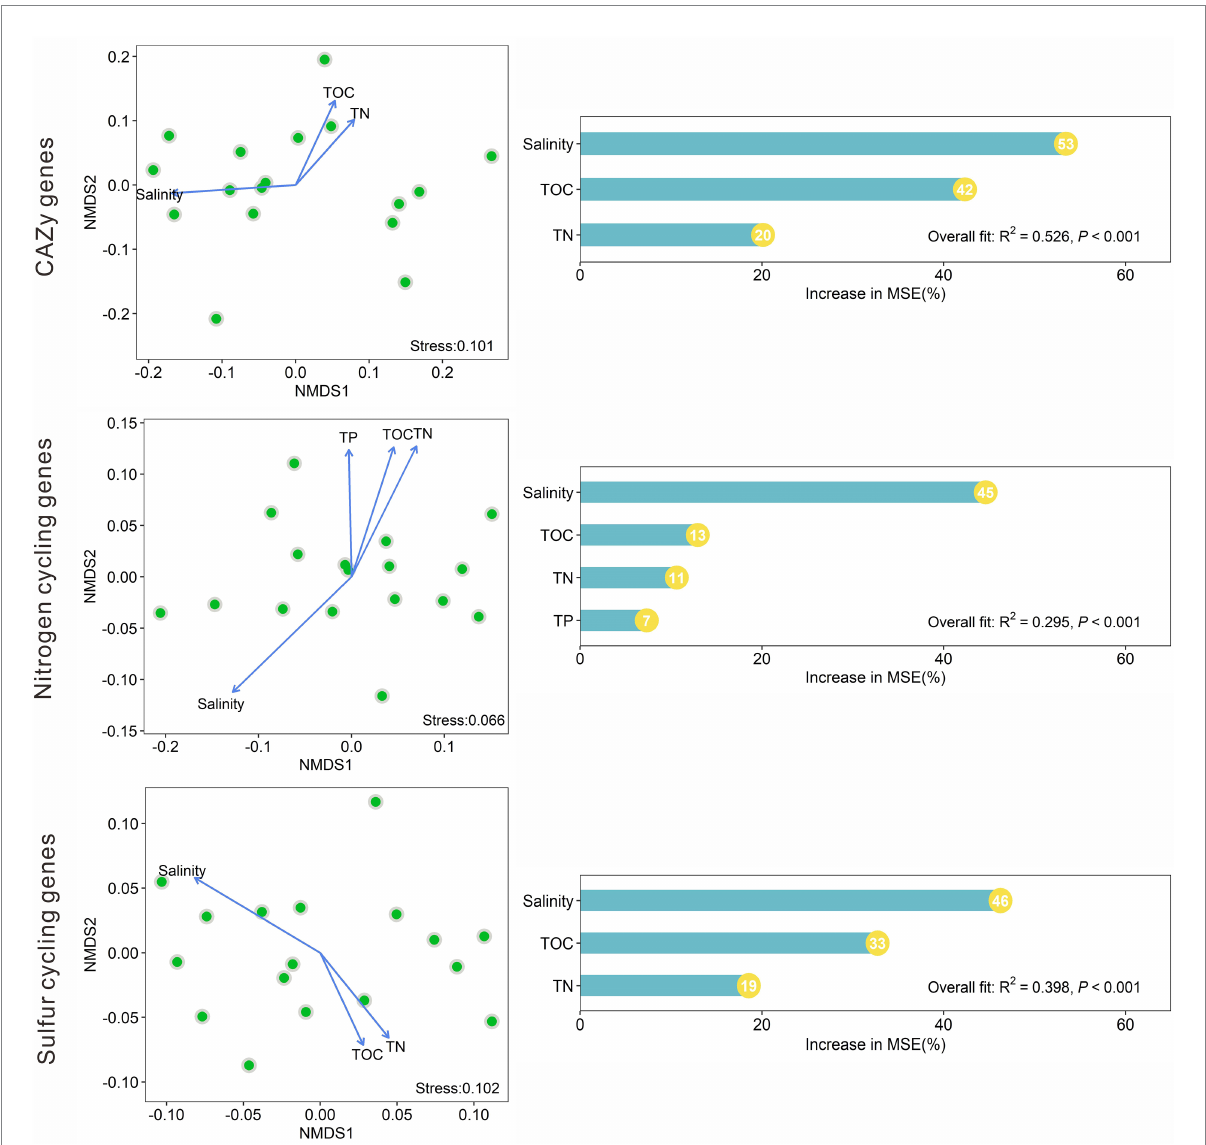
FIGURE 5 Nonmetric multidimensional scaling (NMDS) analyses of the CAZy, nitrogen, and sulfur cycling gene compositions based on Bray–Curtis dissimilarity among the studied lake sediments and their significant ( p < 0.05) influencing factors, and the relative importance of these significant factors in influencing the compositions of the CAZy, nitrogen and sulfur cycling